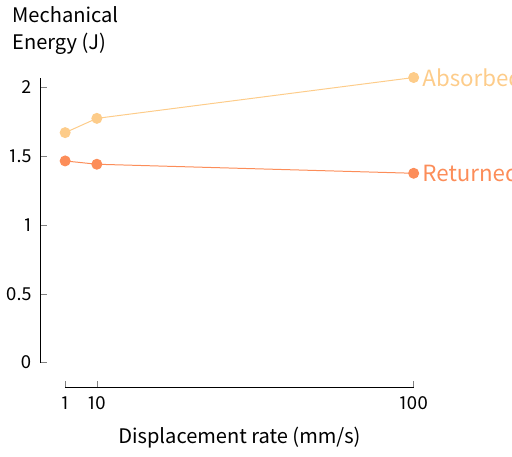
Figure 10. Our DET VSA absorbed more and returned less mechanical energy at faster displacement rates. Thus, it dissipated more mechanical energy at faster displacement rates. These values were calculated by integrating the third tension cycle of the 0kV curves in Figure